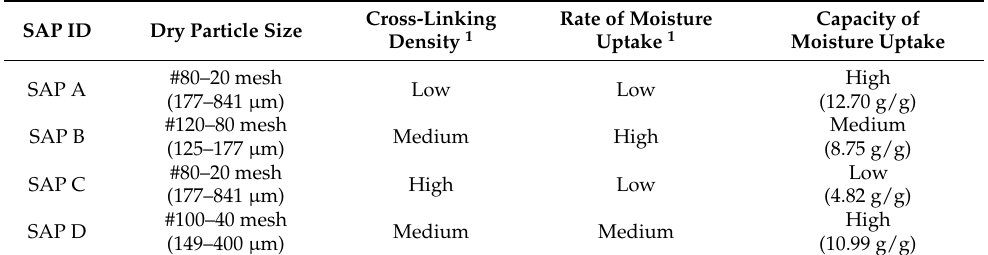
Table 2. General properties of superabsorbent polymer (SAPs) used.